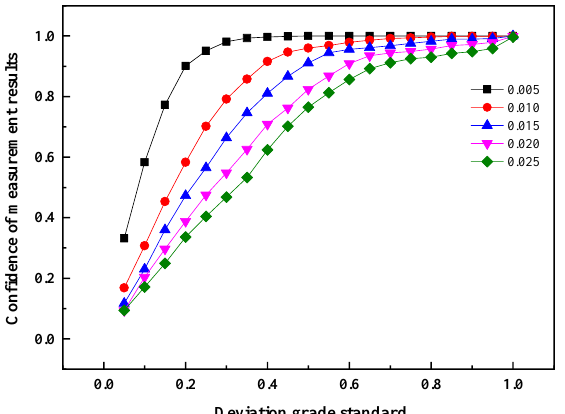
Figure 19. Relationship between deviation grade standard and confidence of measurement results under different relative standard deviations of temperature at velocity 1.35 m/s.